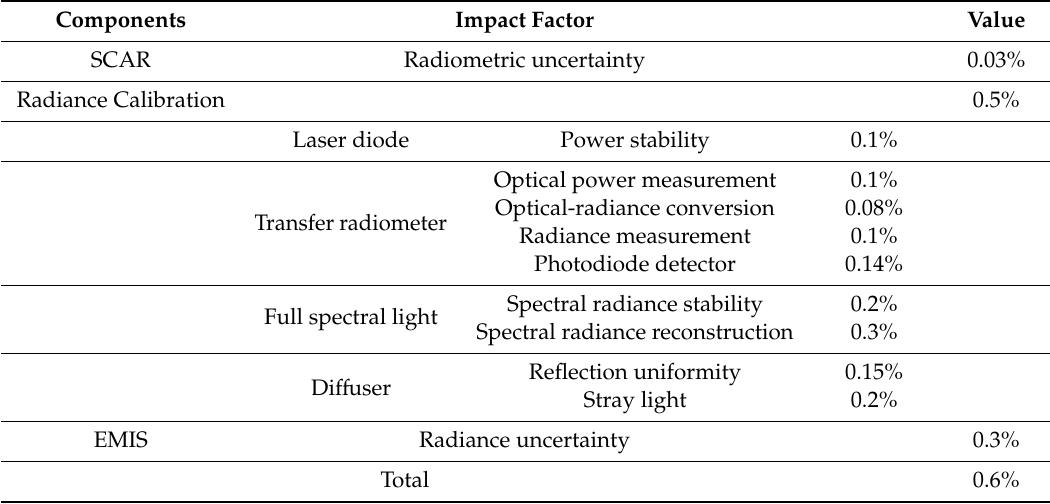
Table 2. Reflected solar spectrum observation